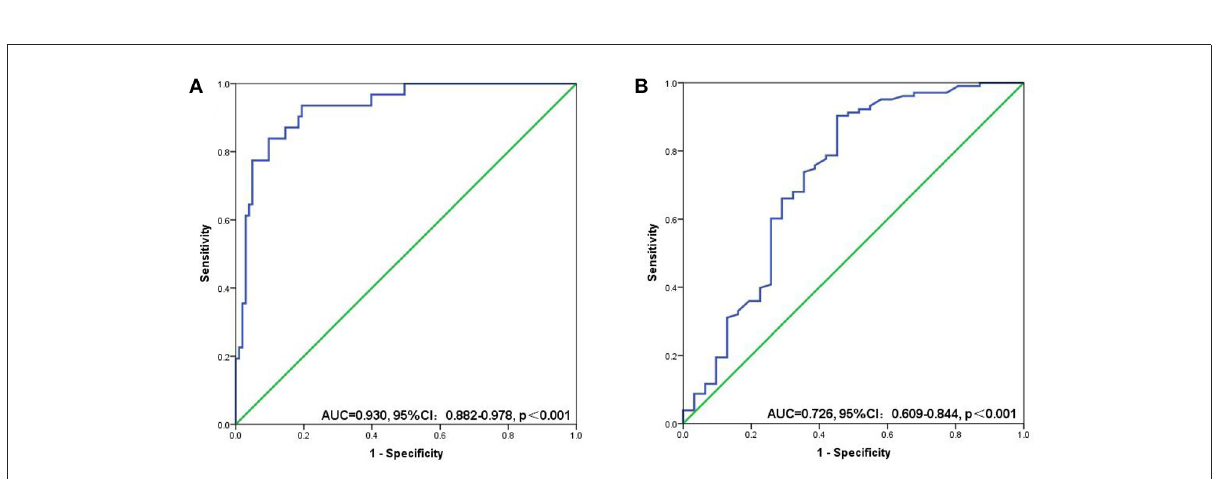
FIGURE5 ROC curves for discriminating patients with sarcopenia and those with non-sarcopenia according to values of the SII (A) and PNI (B) . SII, systemic inflammatory immunity index; PNI, prognostic nutritional index.